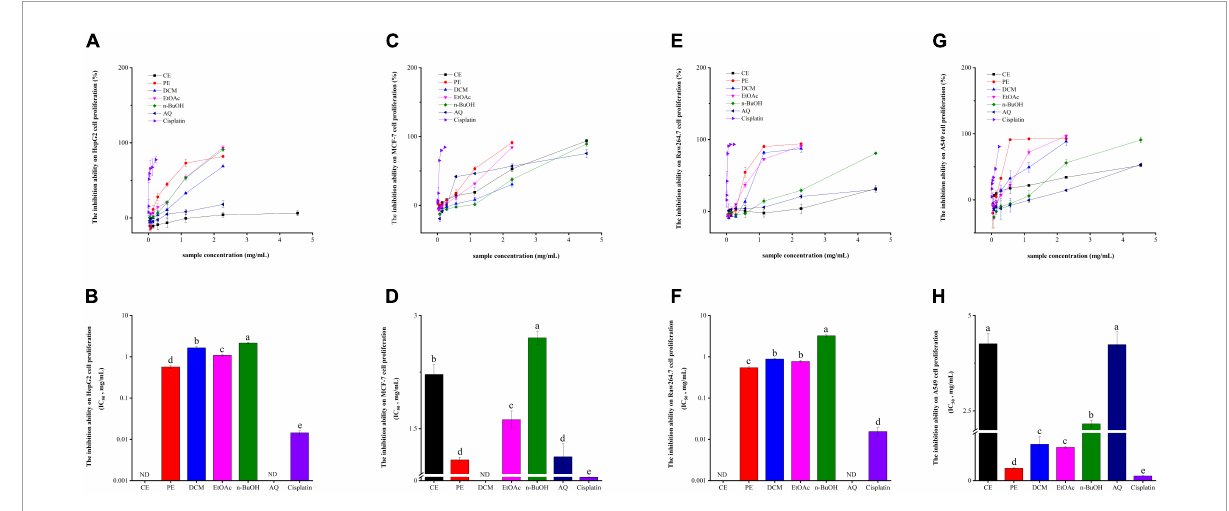
FIGURE4 The HepG2 cell (A,B) , MCF-7 cell (C,D) , Raw264.7 cell (E,F) , A549 cell (G,H) proliferation inhibitory activity of BCF crude extract and its fractions.